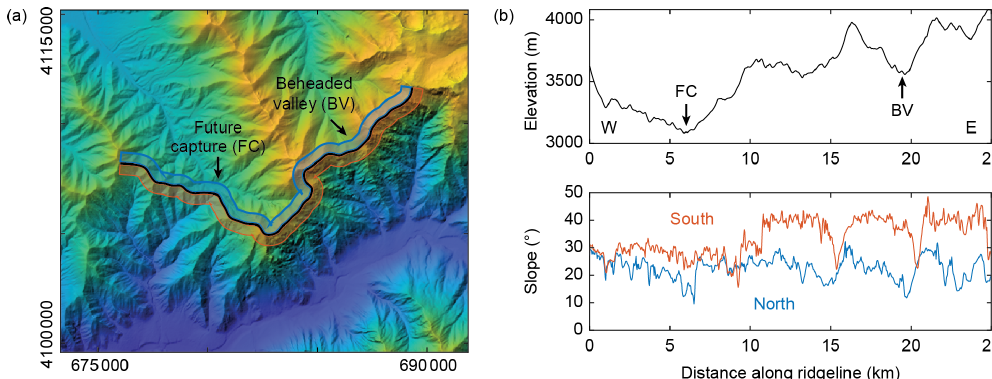
Figure 1. Example of a mobile drainage divide in the Hindu Kush, Afghanistan. (a) Digital elevation model draped over a hillshade image. Colors denote elevations that range from ∼ 2000m (blue) to ∼ 4000m (yellow). The black line traces the drainage divide with clear signs of mobility. The center of the map lies at approximately 37.10 ◦ N and 71.06 ◦ E. North is up and the UTM zone is 43. (b) Profiles of the elevation (upper panel) and mean slope (lower panel) along the drainage divide shown in panel (a) . Mean slope angles were computed along swath profiles that extend 500m to the north (blue) and south (red) of the drainage